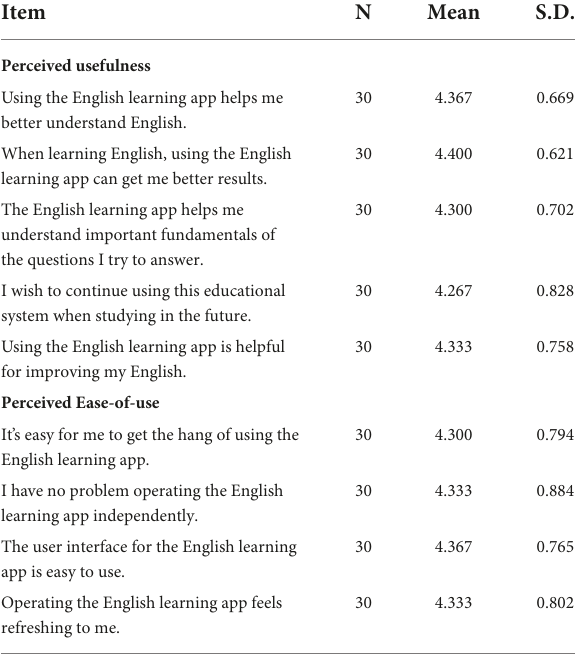
TABLE 2 The result of the technology acceptance